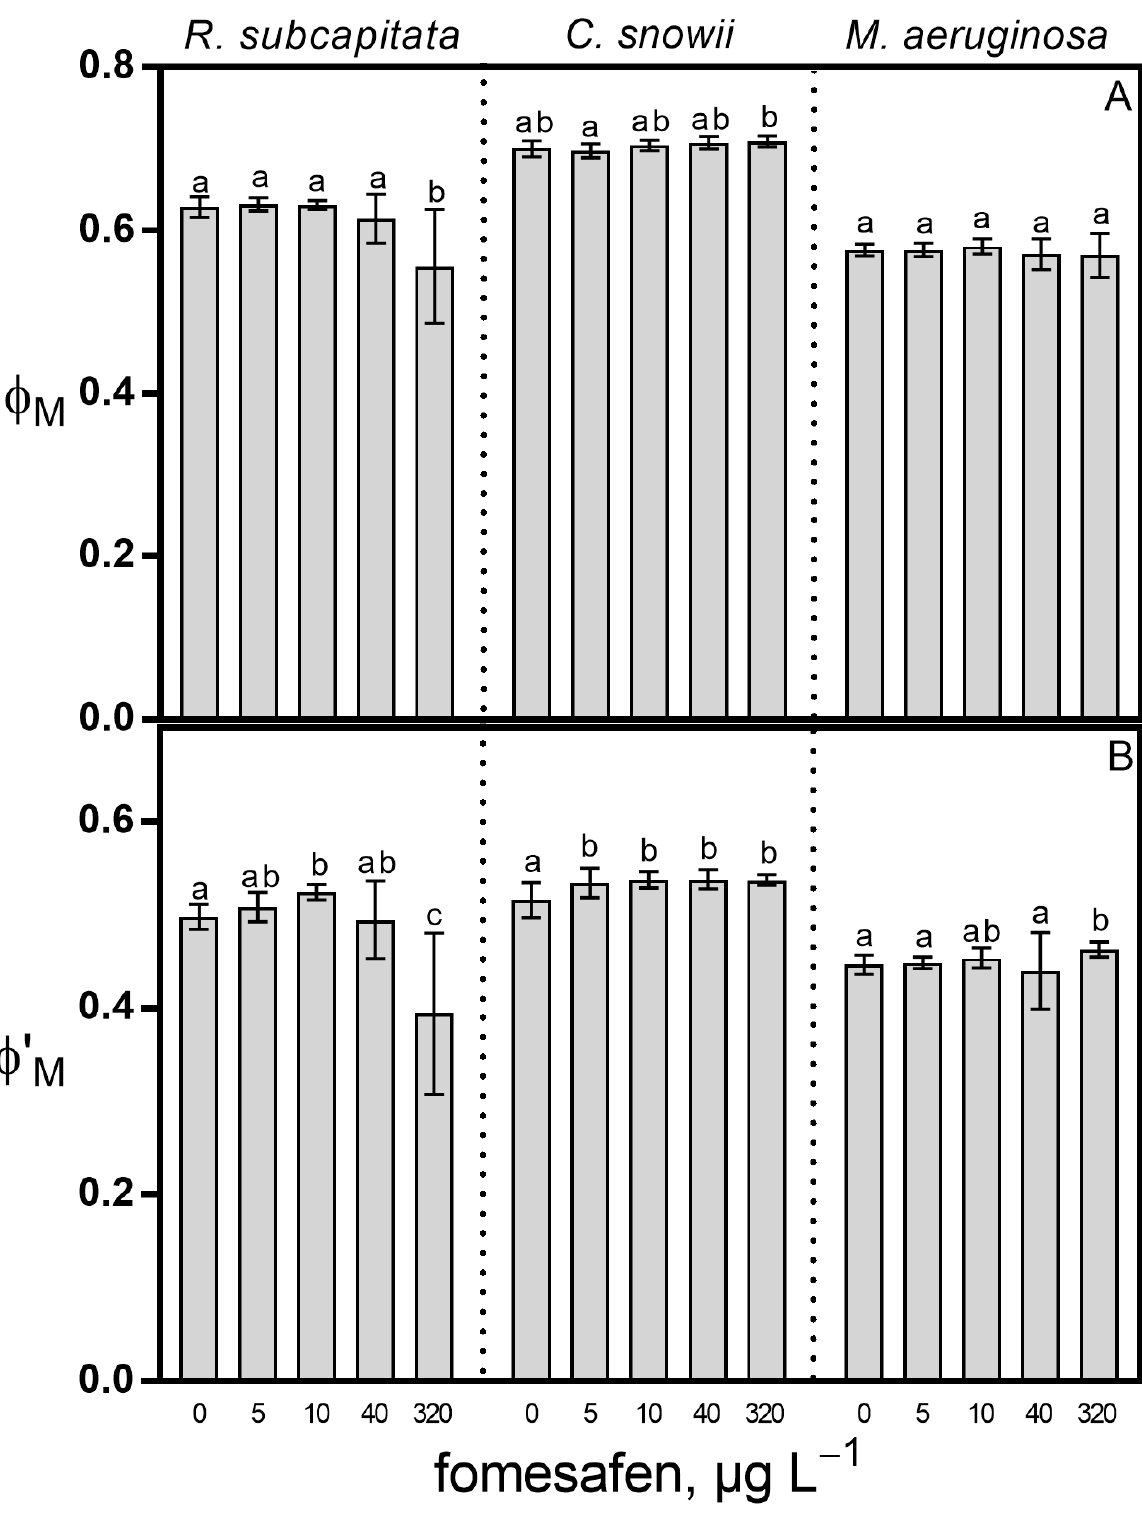
Figure 2. ( A ) maximal ( φ M ) and ( B ) operational ( φ ’ M ) PSII quantum yields of R. subcapitata , C. snowii and M. aeruginosa after 72 h exposure to five concentrations of fomesafen-based herbicide (Reflex ® ; 0, 5, 10, 40 and 320 µg · L − 1 fomesafen a.i.). Bars indicate the means ± standard deviation of nine replicates. Means followed by the same letter are not significantly different by the Tukey–Kramer HSD test or the Kruskal–Wallis test on ranked